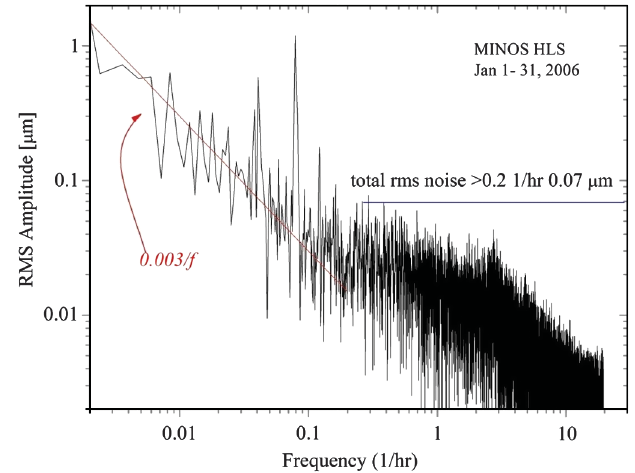
FIG. 40. (Color) FFT of the elevation difference for HLS probes 90 m apart as measured in the Fermilab’s MINOS hall